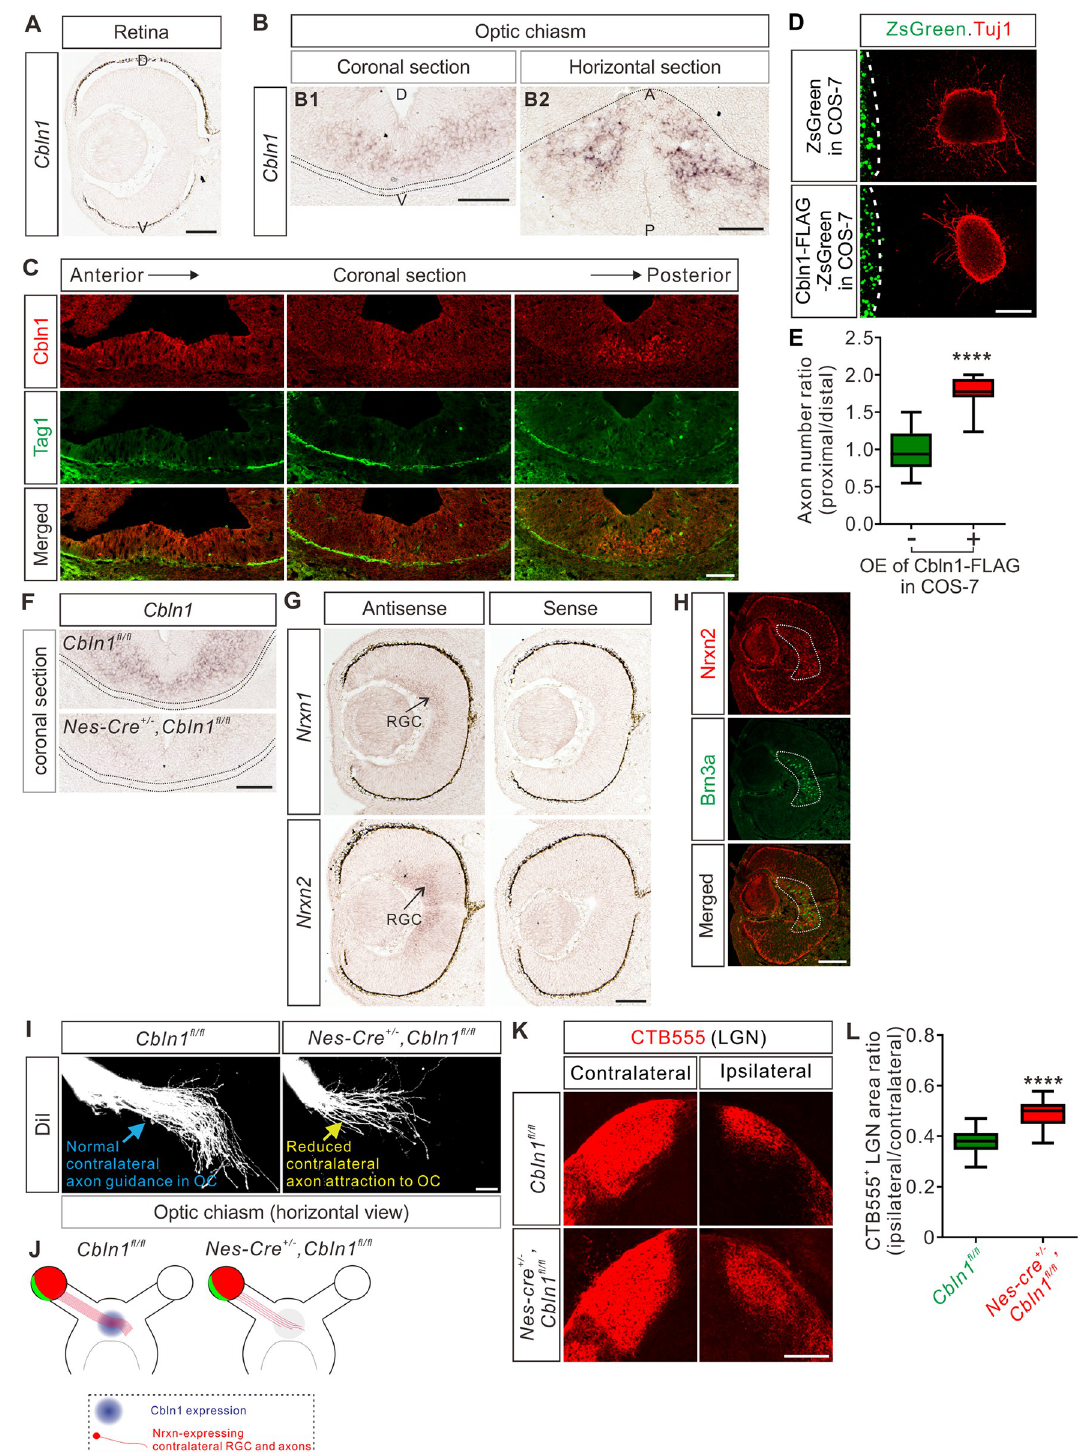
Fig 7. Non-cell-autonomous Cbln1 regulates RGC (retinal ganglion cell) axon guidance in optic chiasm. ( A ) In situ hybridization of Cbln1 in the developing retina. Cbln1 mRNA expression was not detected in the retina of E13 mouse embryos. D, dorsal; V, ventral. Scale bar, 100 μ m.( B ) In situ hybridization of Cbln1 in E13 mouse brain sections (coronal section for B1; horizontal section for B2). Cbln1 mRNA expression was detected in the floor of the third ventricle, adjacent to the optic chiasm. The dotted lines indicate the boundary of the optic chiasm. D, dorsal; V, ventral; A, anterior; P, posterior. Scale bars, 100 μ m. ( C ) Immunostaining